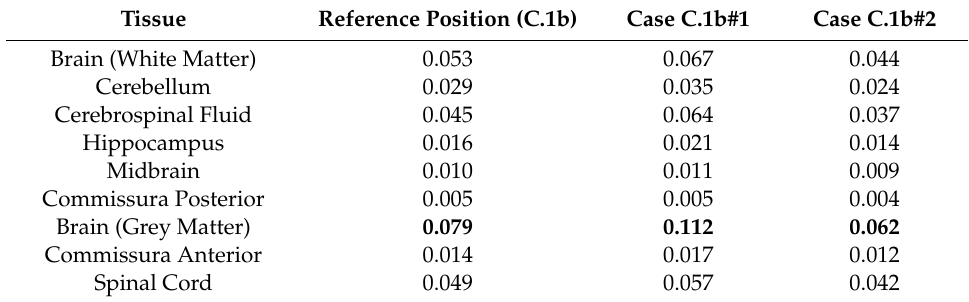
Table 6. Maximum values of E-field (V / m) for the CNS tissues. Influence of body position for posture C.1b. Tissue Reference Position (C.1b) Case C.1b#1 Case C.1b#2 Brain (White